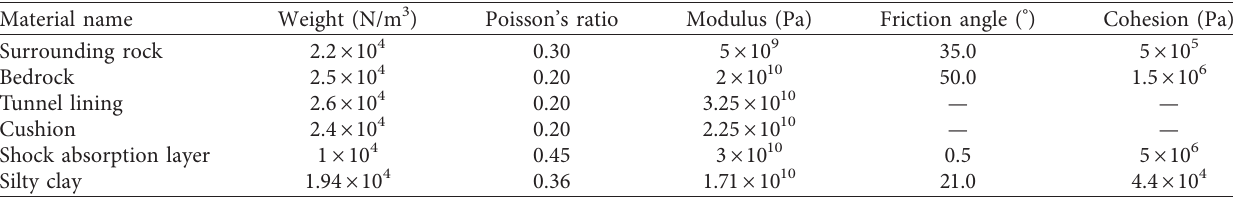
Figure 2: Calculation model. (a) Overall model. (b) Tunnel lining. Table 1: Calculation parameters.